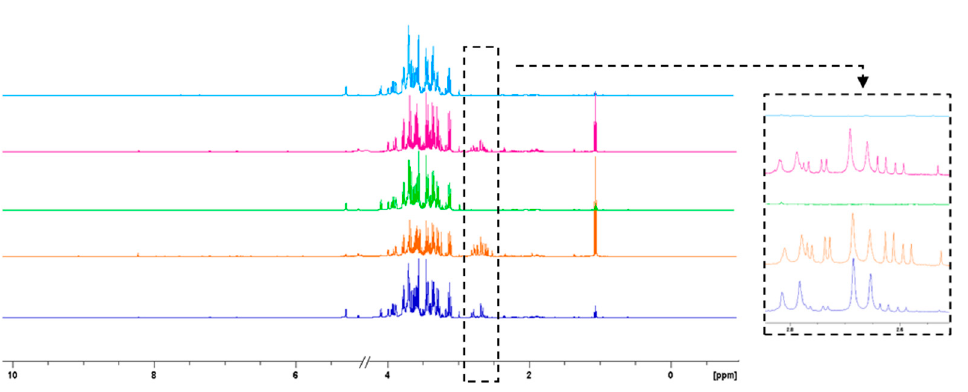
Figure 6. Comparison of 1 H ‐ NMR spectra of Feed NF (in blue), Permeate NF 1 (in orange) Retentate NF 1 (in green), Permeate NF 2 (in fuchsia) and Retentate NF 2 (in light blue) Tacle samples.